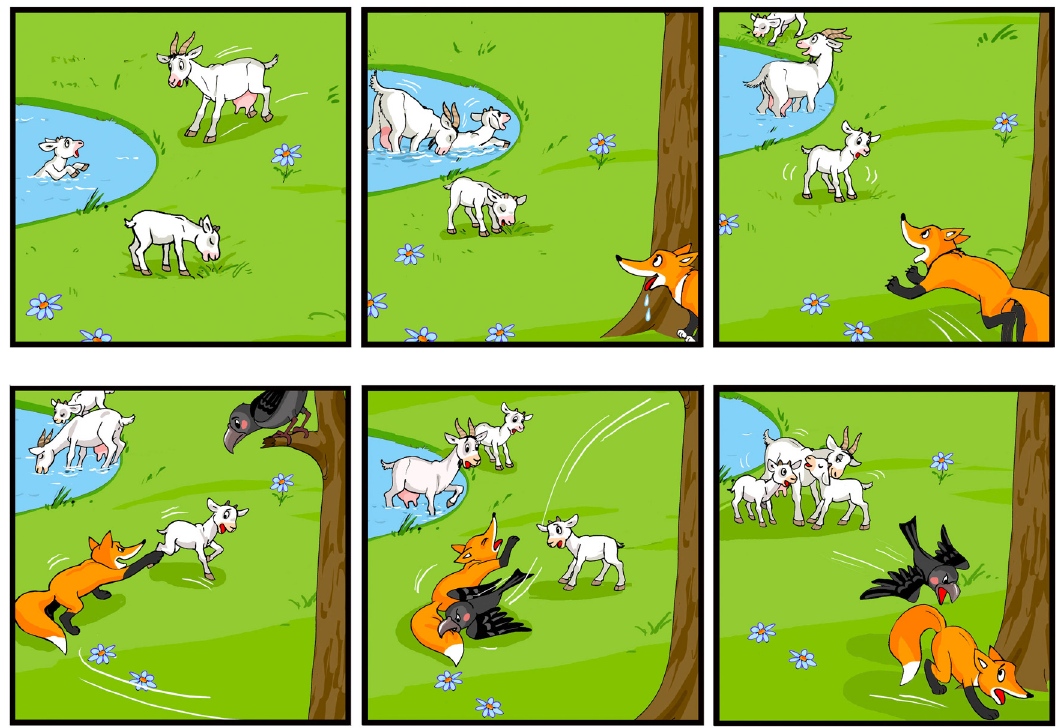
Figure 1: Baby Goats stimulus pictures ( based on Guelzow and Gagarina 2007 )